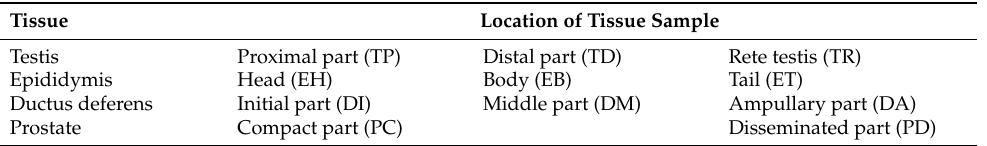
Table 1. Experimental Sampling of Reproductive Tissues during Rutting and Non-Rutting Season from Adult Dromedary Camel Bulls ( Camelus dromedaries